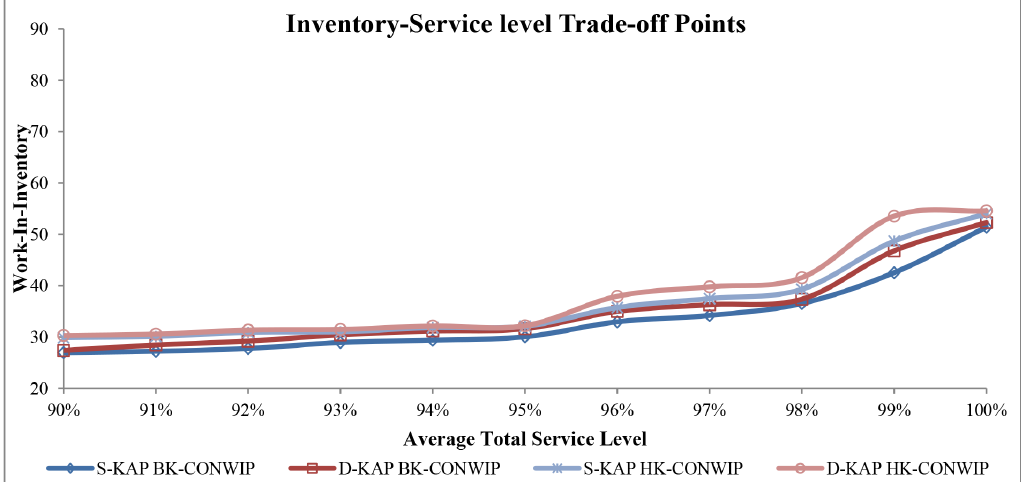
Figure 3. Trade-off between service level and inventory (Case 1)